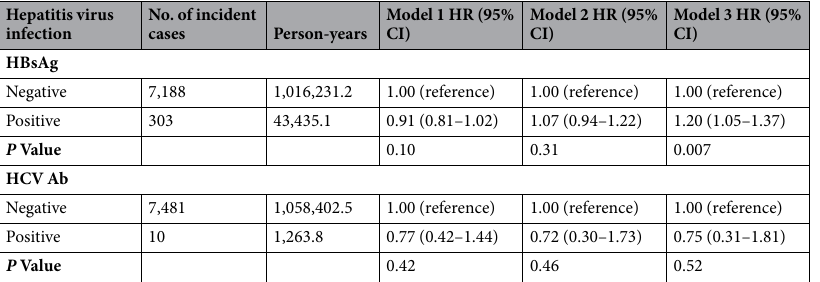
Table 4. Hazard ratios for incident diabetes by hepatitis virus infection status ( n = 219,448). Model 1: adjusted for age, sex, and center; Model 2: further adjusted for smoking (never, former and current), alcohol (none, moderate and high), education ( ≤ 12 years or > 12 years of education), physical activity ( < 3 times/week and ≥ 3 times/week), BMI (continuous), and presence of fatty liver disease; Model 3: further adjusted for initial fasting glucose